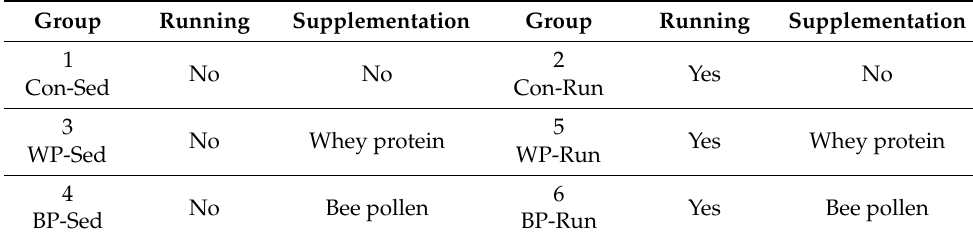
Table 1. Scheme of the